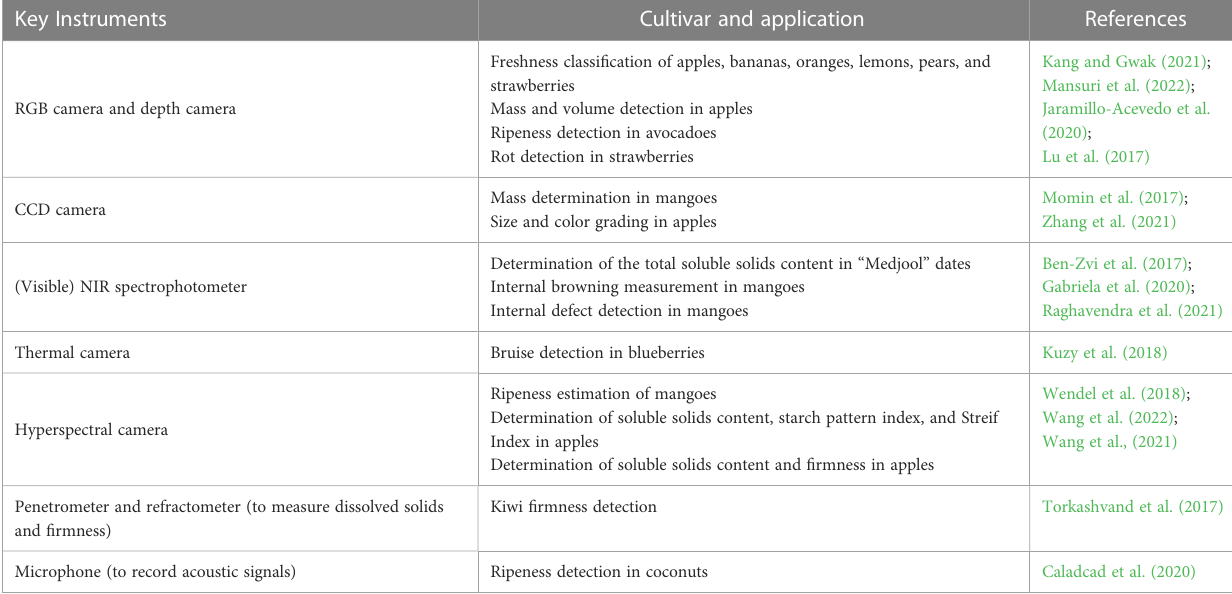
TABLE 2 Key instruments required for on-farm sorting data